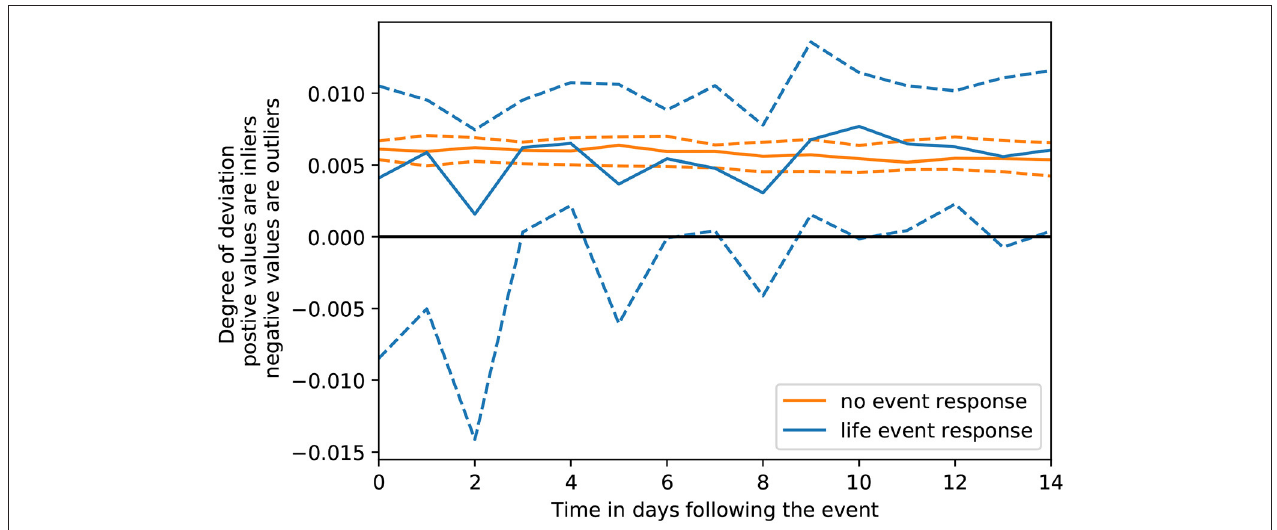
FIGURE 2 | Distribution across time of negative life event response curves compared to no event response